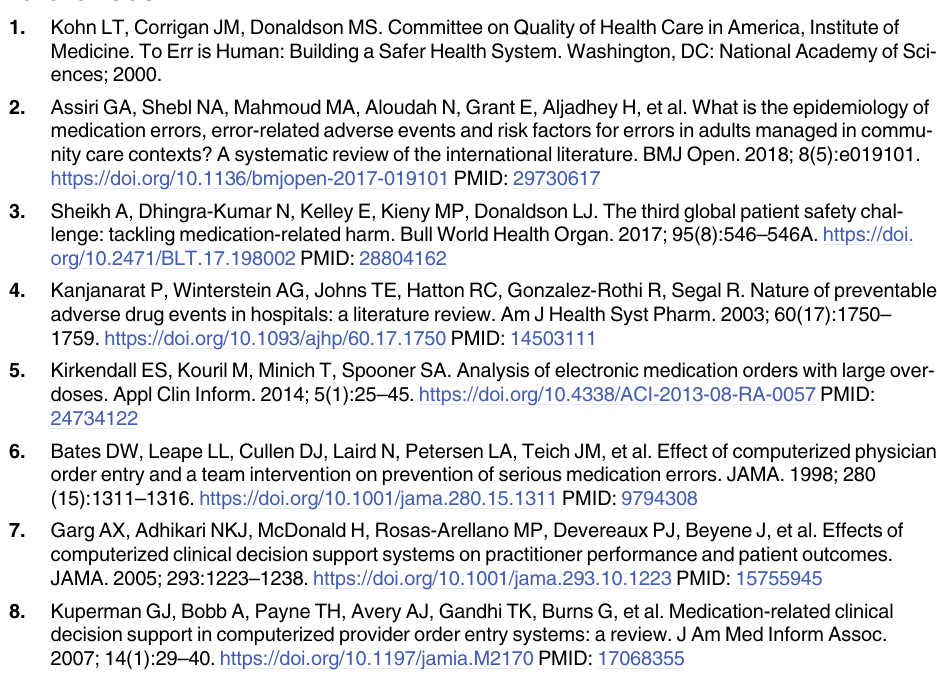
S2 Table. Details of prescription data for phenobarbital